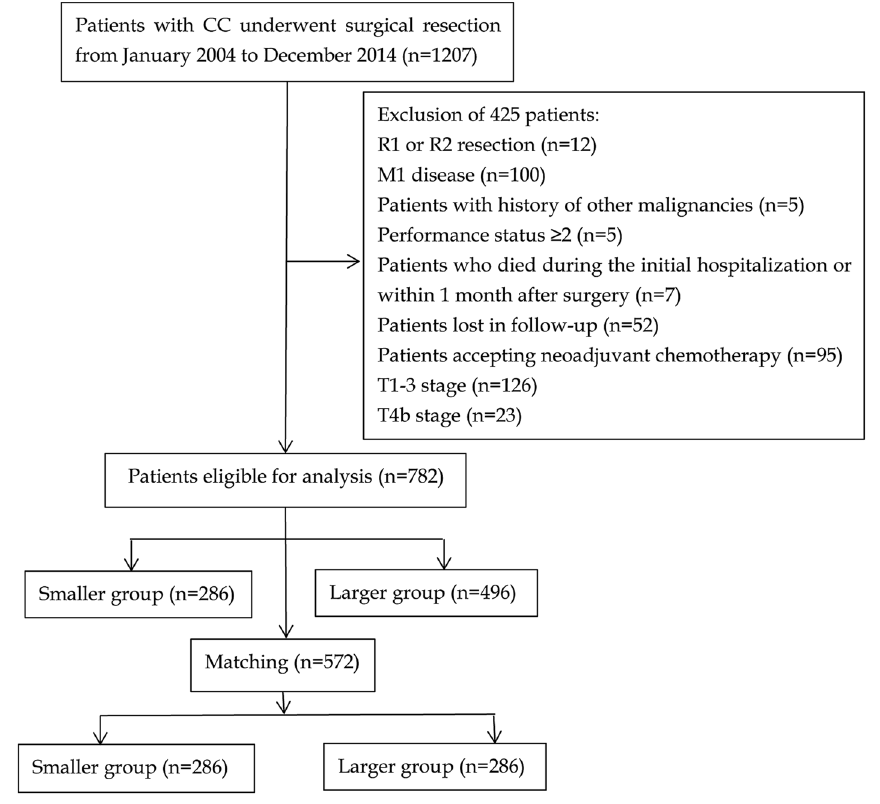
Figure 1. The criteria for inclusion and exclusion of all